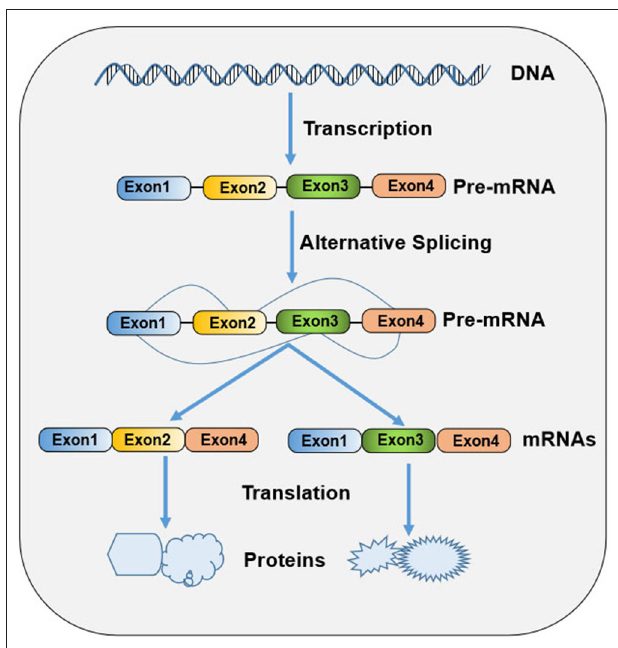
FIGURE 1 | Schematic diagram of gene expression in prokaryote cells.